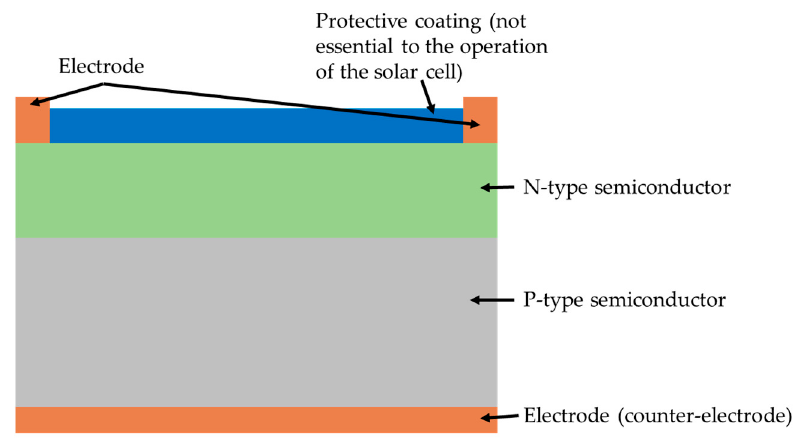
Figure 1. Simple schematic of a typical solar cell comprising of two semiconductor materials (P-type and N-type) and two electrodes.